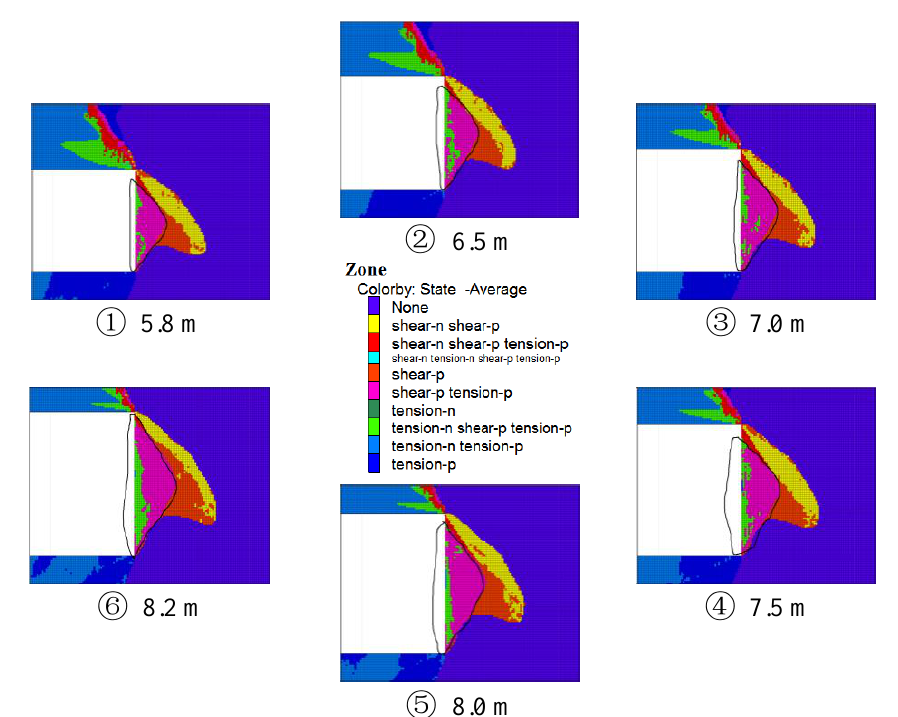
Figure 11. Distribution of rock mass plasticity zones in different mining height coal seams.